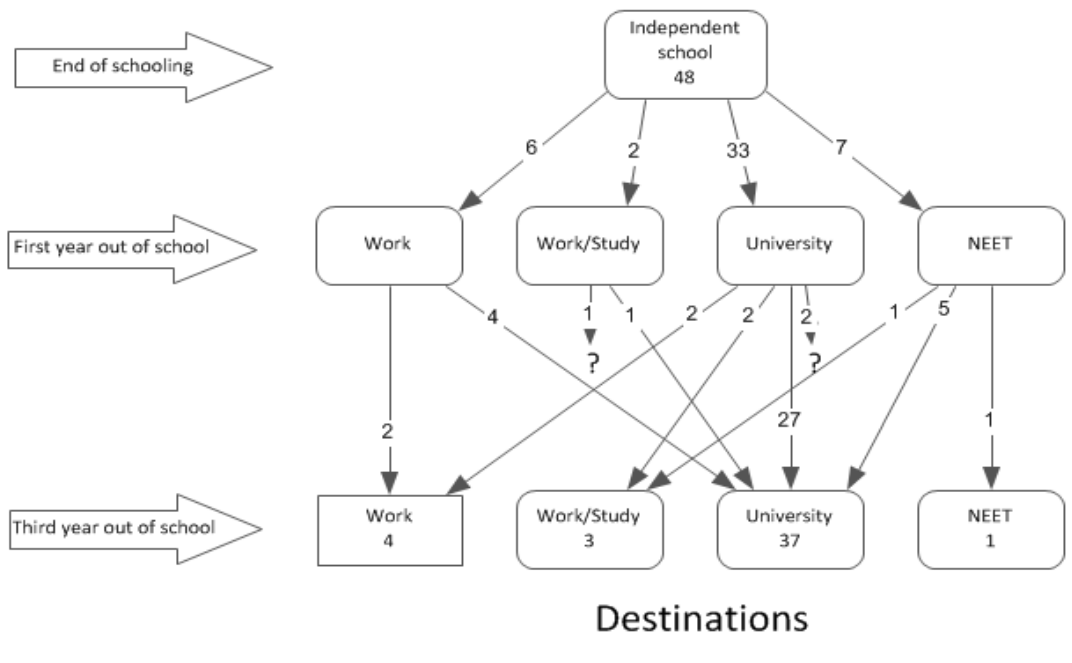
Figure 2 Graphic showing progress of Cohort One Alumni for three